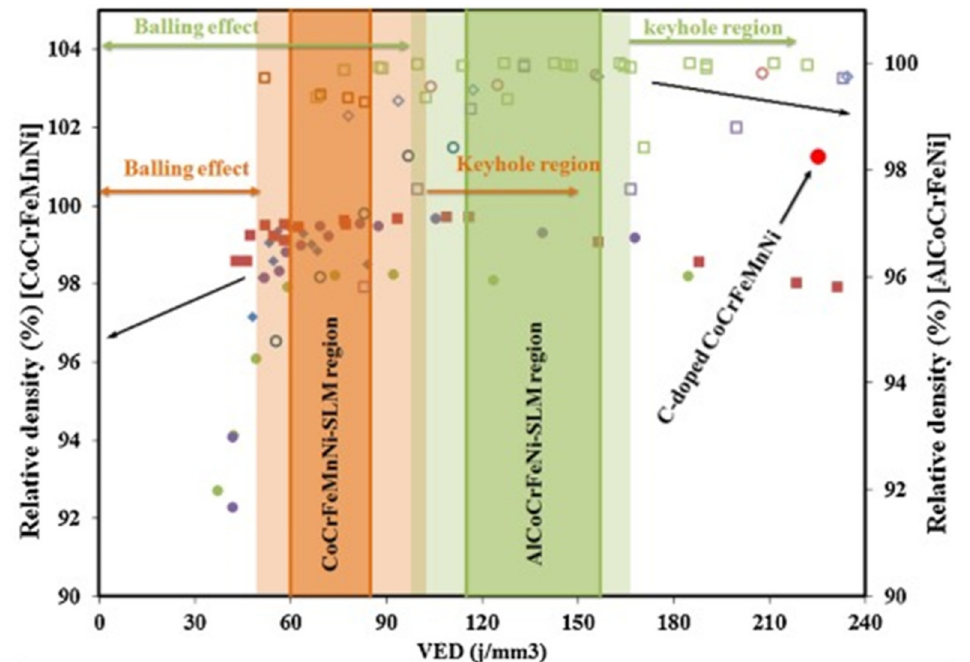
Figure 10. Relative densities of CoCrFeMnNi and AlCoCrFeMnNi HEA fabricated using SLM as a function of VED, indicating the range in which balling, keyhole porosity, and sound printing can happen. Solid and open symbols denoted as to the density of CoCrFeMnNi and AlCoCrFeMnNi HEA, respectively. Reprinted with permission from ref. [351]. Copyright 2021 Elsevier.